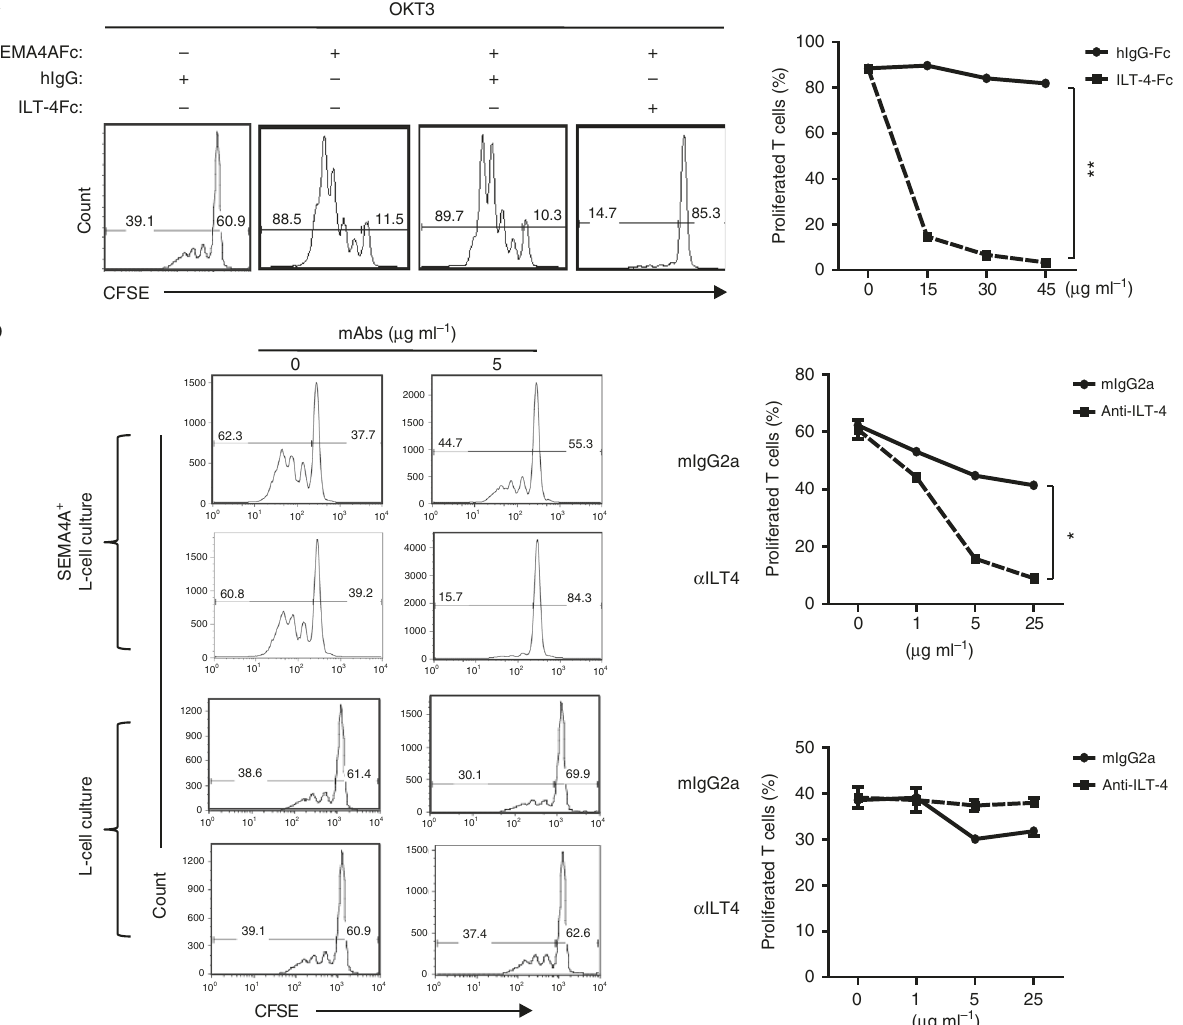
Fig. 6 SEMA4A co-stimulates CD4 + T-cell proliferation through ILT-4 receptor. a , b CFSE-labeled puri fi ed naive CD4 + T cells were cultured in the presence of suboptimal dose of immobilized anti-CD3 mAb plus human SEMA4A-Fc or control hIgG with or without various concentrations of ILT-4-Fc or hIgG for 5 days a , or cultured on parental L cells or SEMA4A-expressing L cells pre-coated with a suboptimal dose of anti-CD3 mAb in the presence of various concentrations of anti-ILT-4 or mIgG for 7 days b . T-cell proliferation was detected by FACS analysis; the percentages of proliferated and non-proliferated T cells are indicated in each squares. The percentages of proliferated T cells in the indicated group were summarized as proliferation blocking curve ( p < 0.01) (Student ’ s T -tests). Data represent one of three independent